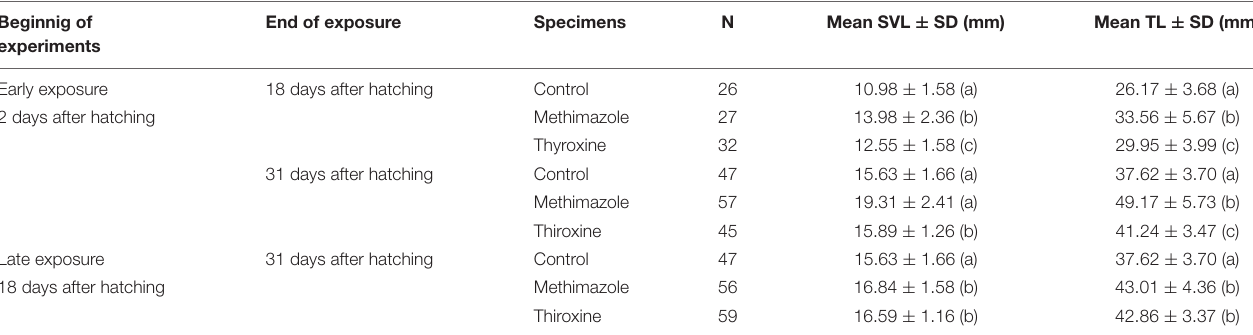
TABLE 3 | Descriptive statistics for snout-vent length (SVL) and total length (TL) of Pleurodema borellii during larval stages comprising pre and prometamorphic stages with exposure to methimazole or